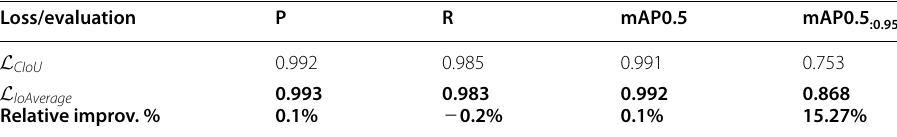
Table 5 Comparison between the performance of yolov5s trained using L CIoU loss and proposed loss. The results are reported L IoAverage on the test dataset of vld100k-61 Loss/evaluation P R mAP0.5 mAP0.5 :0.95 L CIoU 0.992 0.985 0.991 0.753 L 0.993 0.983 0.992 0.868 IoAverage Relative improv. % 0.1% 0.1% − 0.2% Bold indicates the experimental comparison results on yolov5s using the method proposed in this paper